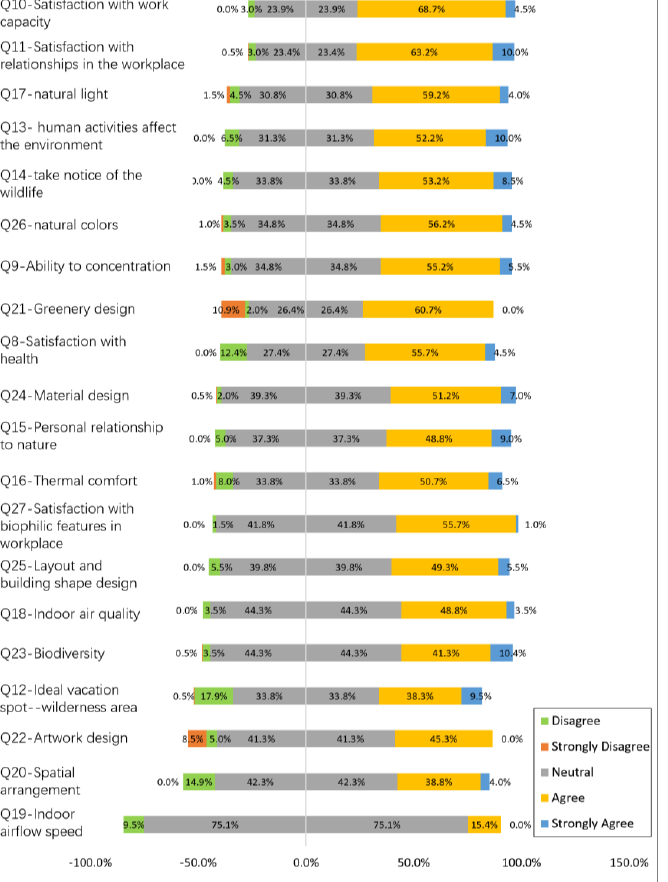
Figure 2. Stacked graph with percentage responses for individually arranged items (from the bottom with a high percentage of disagreement to the top with a high percentage of agreement).